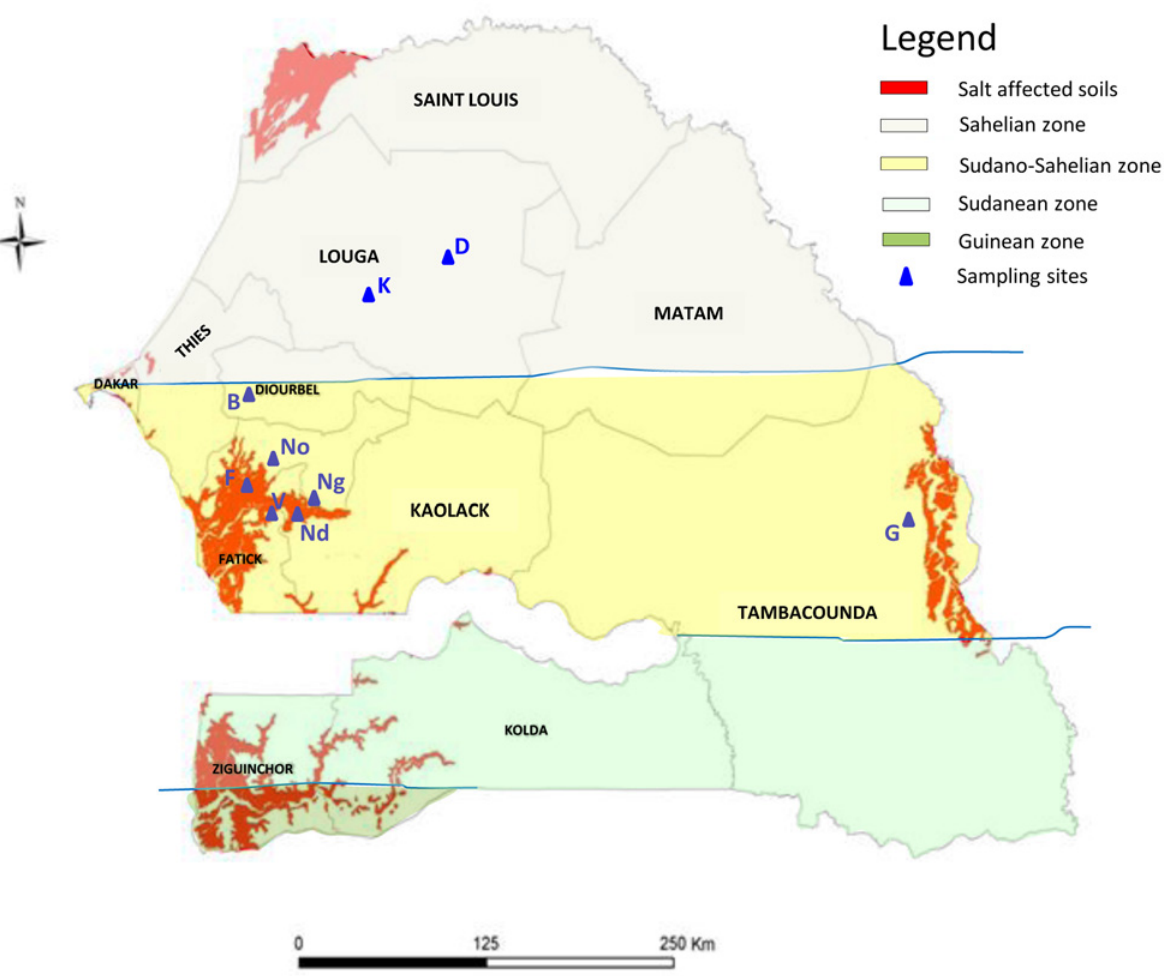
Fig 1. Localization of sampling sites in Senegal. Sampling sites are indicated in blue (D = Dahra, K = Kamb, B = Bambey, F = Foundiougne, Ng = Ngane, V = Vélor, Nd = Ndiafate, No = Nonane, G = Goudiry). The red color indicates salt affected soils (Electroconductivity > 4000 μ S cm -1 ). Background colors indicate the different climatic zones of Senegal: light yellow = Sahelian zone (annual rainfall 250 – 500 mm), Dark yellow = Sudano-Sahelian zone (annual rainfall 500 – 900 mm), light green = Sudanean zone (annual rainfall 900 – 1100 mm), dark green = Guinean zone (annual rainfall > 1100